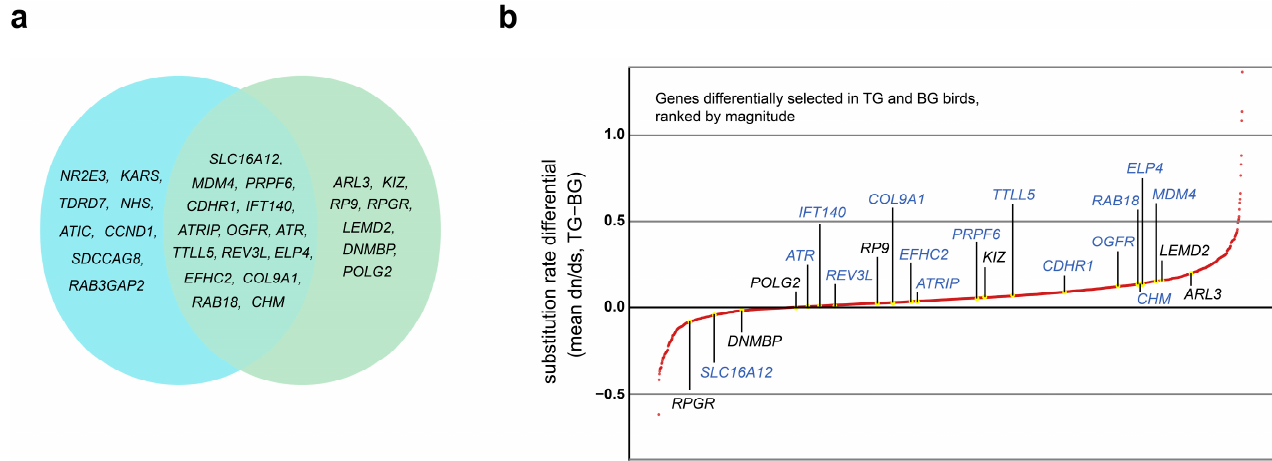
Figure 2. ( a ) The Venn diagram shows visual-degradation candidate genes identified in positive selection analysis; 23 genes in the blue circle were positively selected in tactile-foraging birds, and 22 genes suffered significantly different selective pressures between the tactile-foraging group (TG) and the background group (BG) birds. ( b ) All genes with significantly different selective pressures (nonsynonymous to synonymous substitution ratios ( dn / ds or ω )) between TG and BG birds were marked in red. A subset of 22 visual-degradation candidate genes were marked in yellow, and 15 sharing genes were also highlighted in blue .